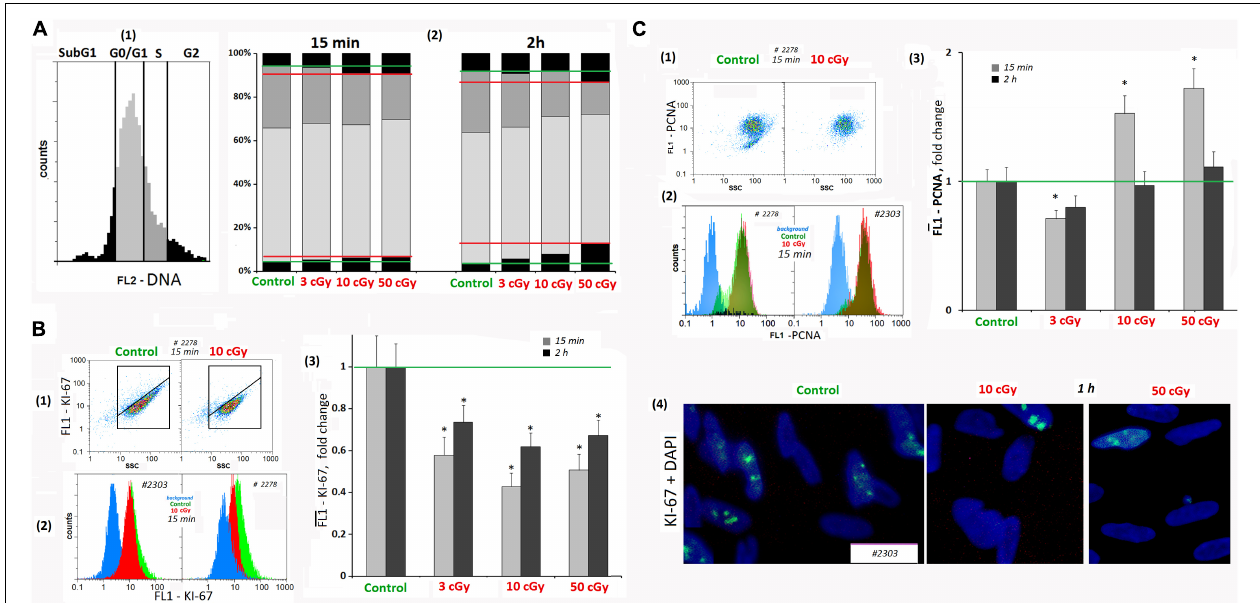
FIGURE 6 | LDIR induce cell cycle arrest in MSCs. (A) FACS. The DNA amount in the MSCs (cell nuclei staining with PI). (1 and 2) MSC fractions with the DNA amount corresponding to the Sub G1, G0/G1 -, S -, and G2/M cell cycle phases. The cultivation times and radiation doses are shown in the figure. (B) FACS (1–3). Cell nuclei staining with FITC-labeled antibody against KI-67. (1) Plots: FL1- KI-67 versus SSC. (2) The distribution of the MSCs (10 cGy, 15 min after LDIR) with varying FL1–KI-67 signal. (3) Median signals for FL1–KI-67. (4) Fluorescence microscopy. Localization of FITC-labeled antibody against KI-67 in the irradiated MSC (10 and 50 cGy) and MSC (C) . Average values and SD are given for three experiments. * p < 0.001 ( U test). (C) FACS. Cell nuclei staining with FITC-labeled antibody against PCN (A). (1) Plots: FL1- PCNA versus SSC. (2) The distribution of the MSCs (10 cGy) with varying FL1–PCNA signal. (3) Median PCNA signals.